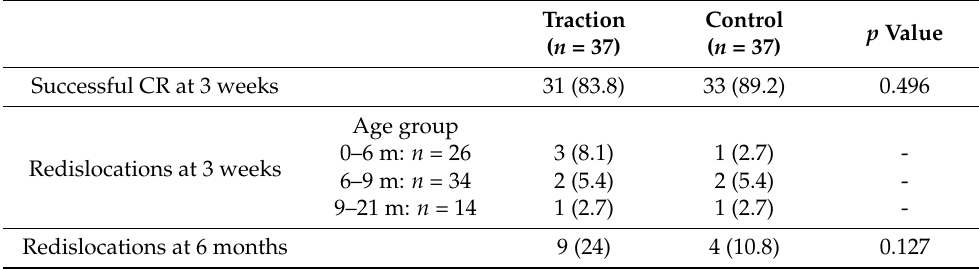
Table 2. Primary and secondary outcomes of